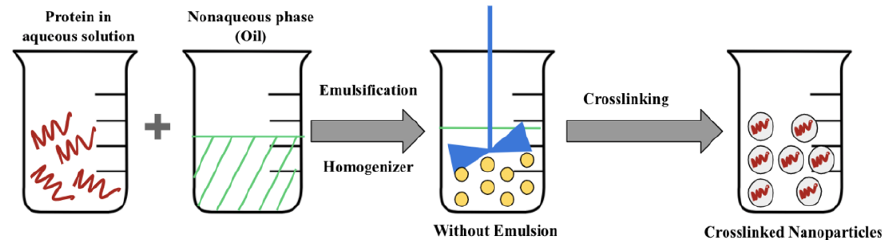
Figure 1. Emulsification/Solvent Extraction—The drug is dissolved in the polymer solution and an emulsion is formed by mechanical agitation. The polymer and drug are precipitated in droplets and NPs are fabricated by solvent extraction by evaporation.